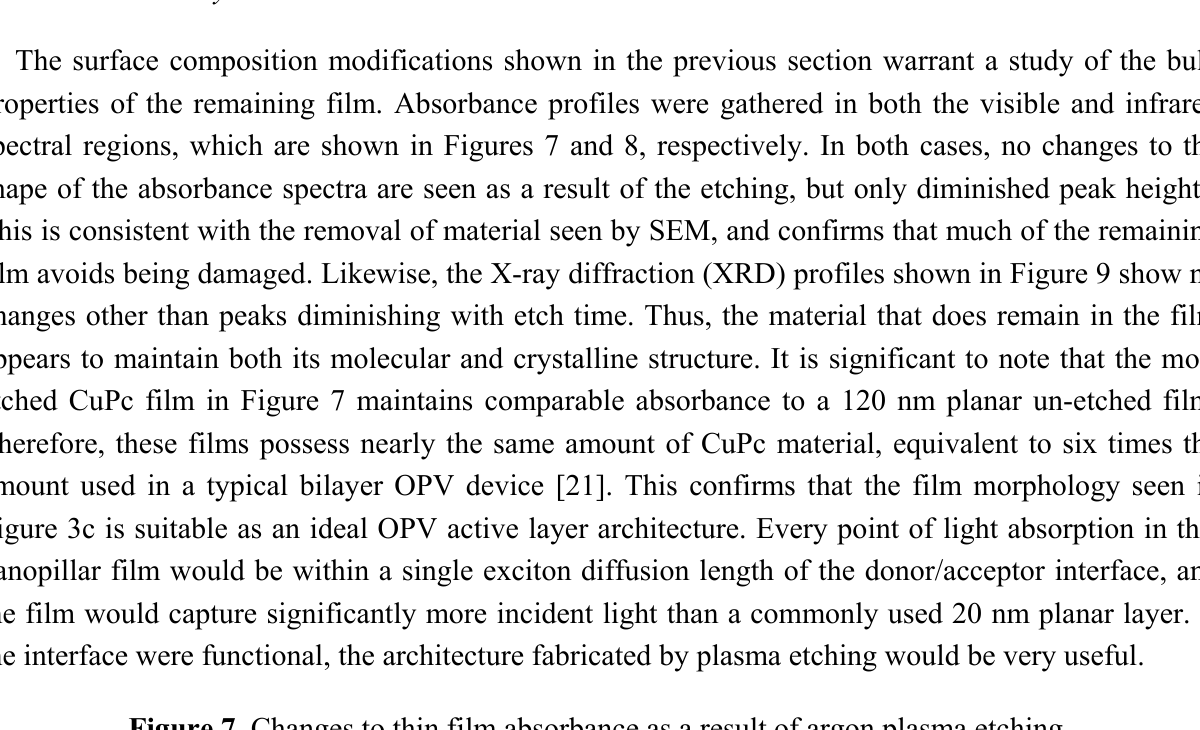
Figure 7. Changes to thin film absorbance as a result of argon plasma